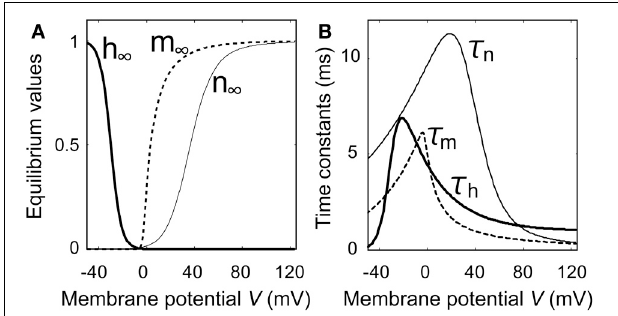
FIGURE 6 | Characteristics of gate parameters as a function of membrane potential. (A) Equilibrium values of gate parameters. (B) Time constants of gate